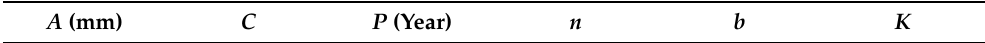
Table 2. The range of parameters in Equation (3).